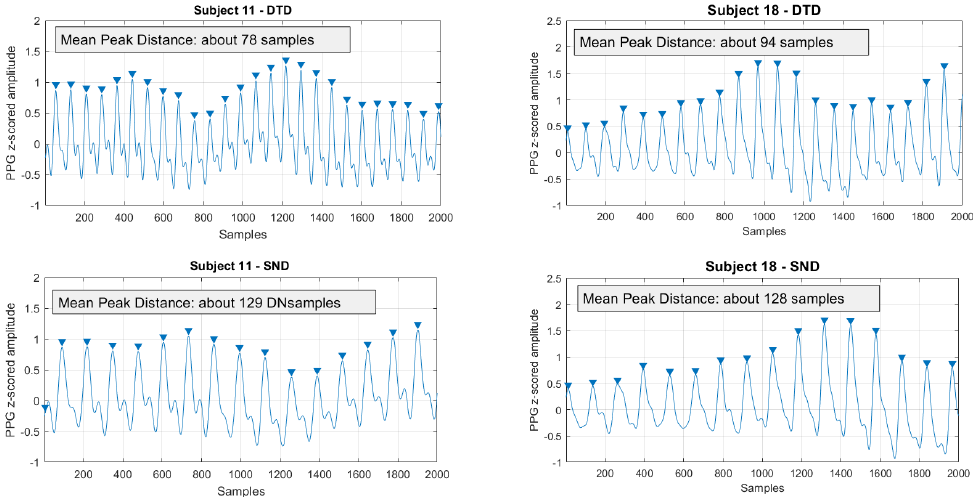
Figure 4. PPG data in resting state conditions for Subjects 11 ( left ) and 18 ( right ) are herein reported, in the original discrete time domain (DTD) and in the Subject Normalized Domain (SND) ( top and bottom rows, respectively). Before the proposed normalization ( top row), the subjects have different heartbeat frequencies, while, in the SND, they are more similar. Algorithm 1 Pseudocode of the personalized PPG normalization applied to the signals of subject